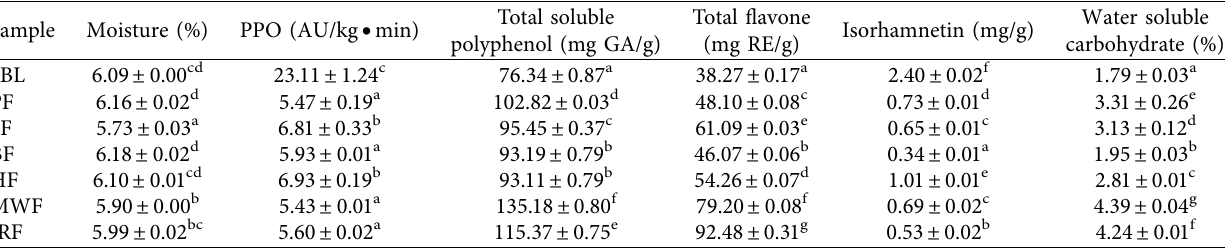
Table 1: Moisture, polyphenol oxidase (PPO), total soluble polyphenol, total favonoid, isorhamnetin, and water-soluble carbohydrate of sea buckthorn leaf